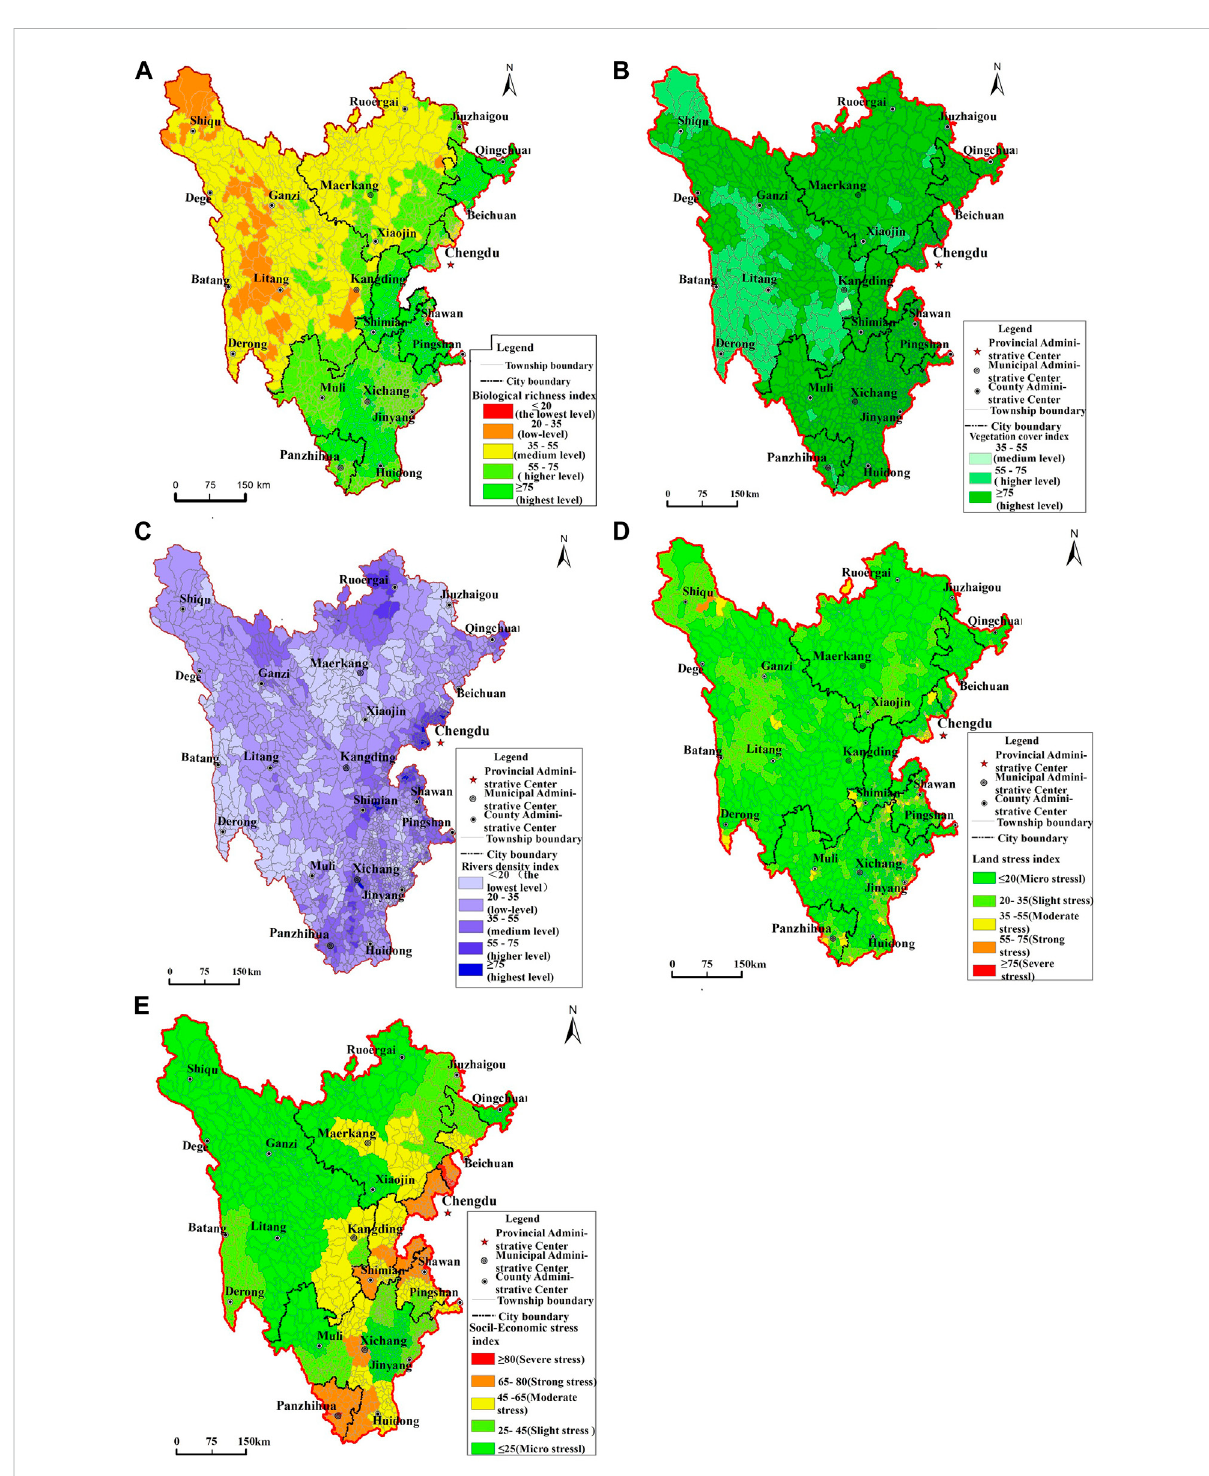
FIGURE 7 Assessmentindicatorinyear2019. (A) Biologicalrichnessindex, (B) Waternetwork densityindex, (C) Vegetationcoverageindex, (D) Landstress index, (E) Social-economic stress